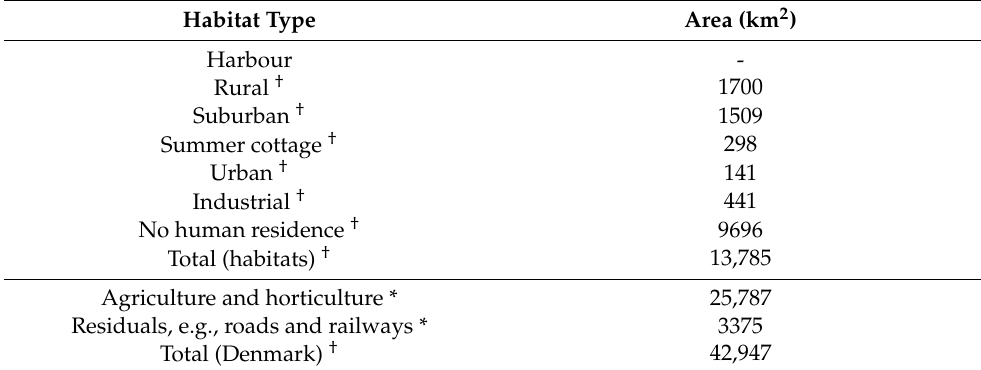
Table 1. Habitats and land use in Denmark in km 2 . The habitat type ‘no human residence or commercial use’ includes lakes, basins, runways, raw material areas, wetland, forest, scrub vegetation, moor and sand